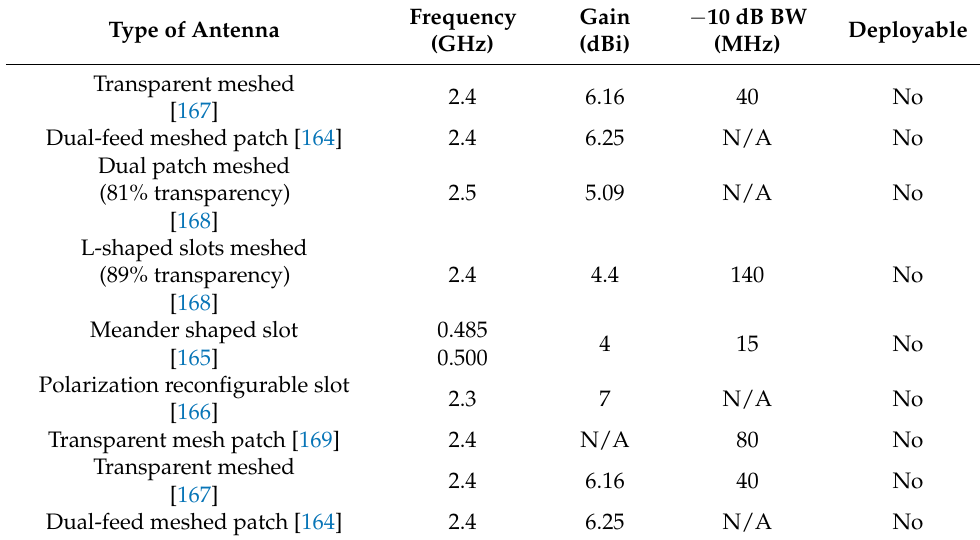
Table 8. Performance of meshed planar antennas.